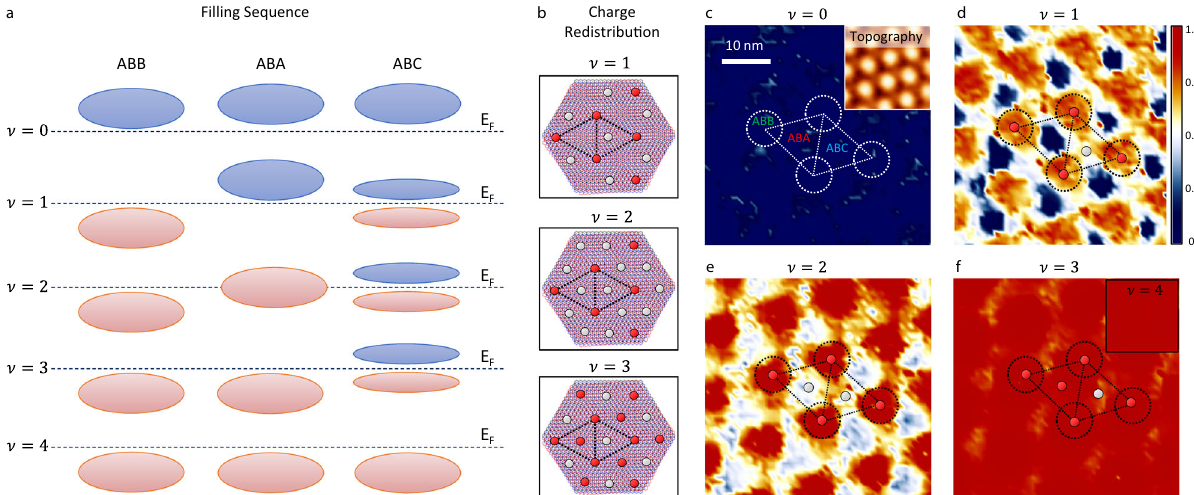
Fig. 3 Electron crystal. a Schematic drawing shows fi lling sequences of ABB, ABA, and ABC regions as a function of global fi llings ν that is listed on the left. The dashed lines indicate the E F at each fi lling factor. The red (blue) ovals represent the CFB with (without) electrons occupation. b Summarized charge redistribution and the electron crystal from Figs. 2 and 3. Red (gray) circles superposed on three high-symmetry regions indicate the positions fully (partially) occupied by electrons. c – f Extracted local fi lling ratio, R , from every d I /d V curve in d I /d V maps for different fi lling factors ν ¼ 0 ( c ), ν ¼ 1 ( d ), ν ¼ 2 ( e ), ν ¼ 3 ( f ), and ν ¼ 4 (inset of f ) ( V = − 100 mV, I = 200 pA). The inset in c shows topography simultaneously obtained during d I /d V maps, b which can offer the structure of the moiré superlattice and the position of three high-symmetry regions (white dotted rhombus structures in c – f ). The red (gray) circles superposed on these maps represent areas with full (partial) fi lling, which have similar superstructures with those in ( b ). The color bar shows the local fi lling ratio ( R ) from 0 to 1.